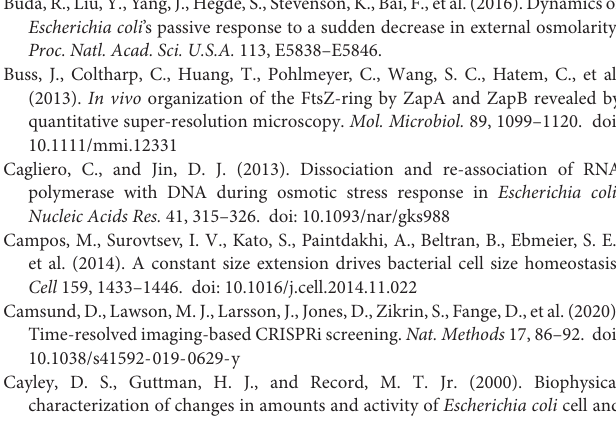
Supplementary Figure 1 | The distribution of steady-state growth rates is similar in microfluidic devices and on agarose pads. Supplementary Figure 2 | GFP-ZapA concentration increases directly after a hyperosmotic shock. This increase was consistent with the decrease in cytoplasmic volume ( Figure 1B ) and the increases in FtsZ-msfGFP and cytoplasmic GFP ( Figure 4C ). Supplementary Table 1 | Strains used in this